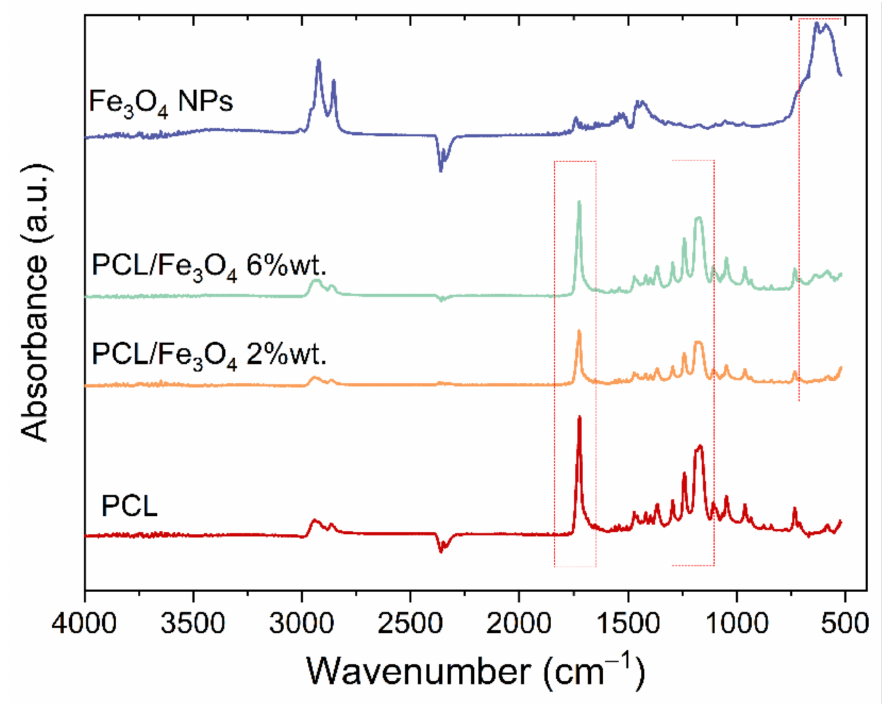
Figure 2. ATR-IR spectra of plain PCL nanofibres, electrospun PCL/Fe 3 O 4 NPs (2 and 6 wt.%) and Fe 3 O 4